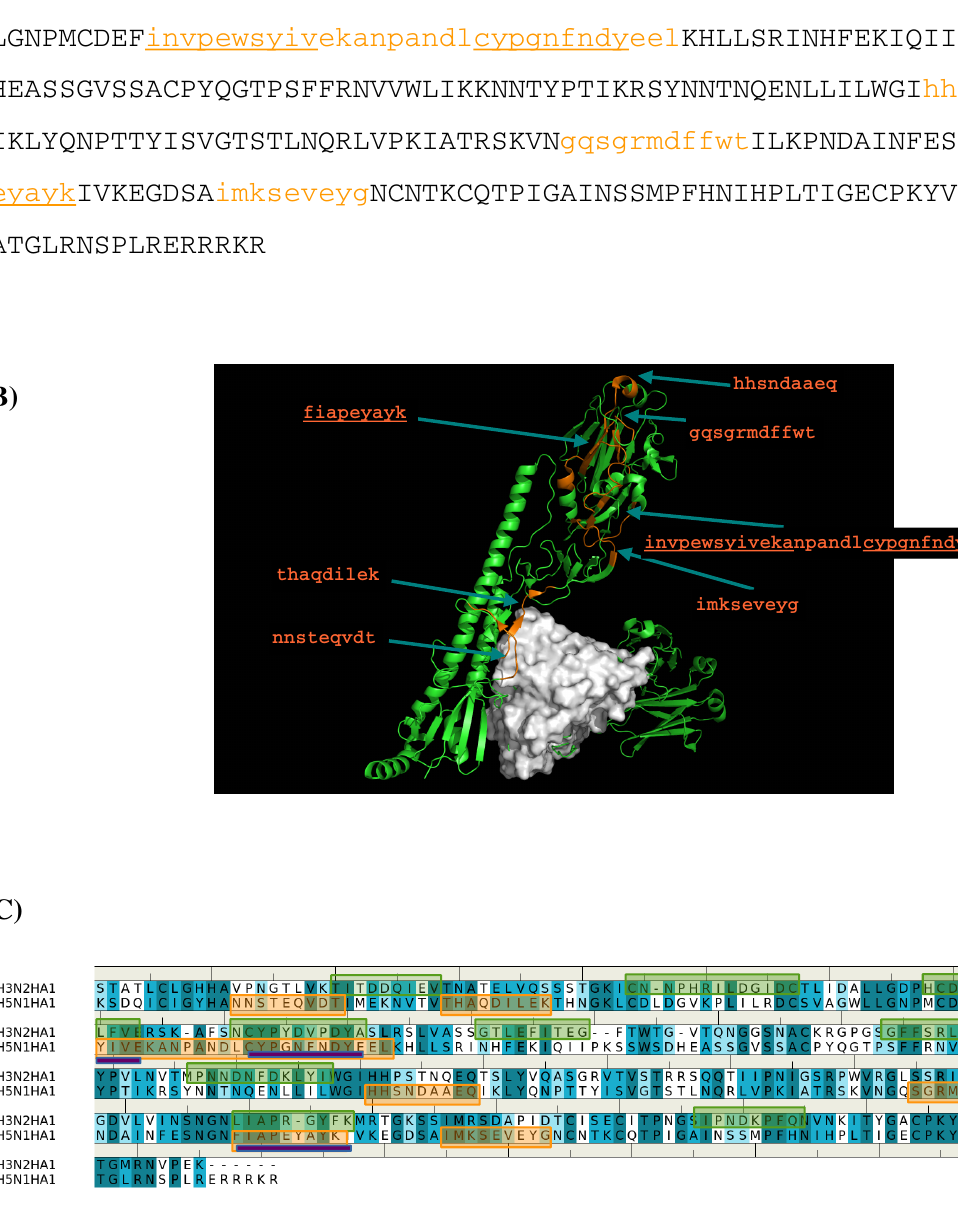
Figure 6. ( A ) the predicted epitopes of H5N1 HA1 ( A ) binding to antibody CR9114. The epitopes are highlighted in lower case and colored orange in the protein sequence. ( B ) Backbone representation of the antigen H3N2 HA1 showing the predicted epitopes in orange and the antibody in surface. ( C ) Sequence alignment of HA1 protein of influenza viruses H3N2 and H5N1. The boxes highlight the epitopes predicted for H3N2 ( green ) and H5N1 ( orange ). The overlay regions between two subtypes are underlined in purple. Figures were prepared using PyMOL